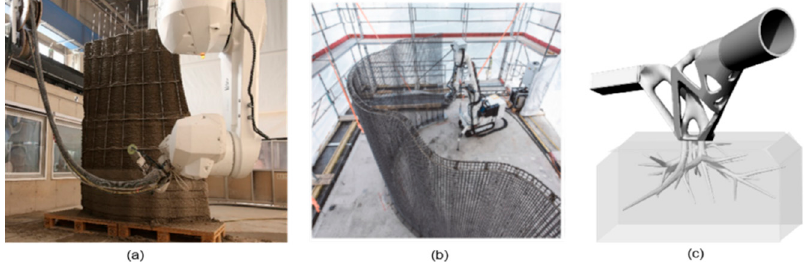
Figure 1. ( a ) Construction of a reinforced concrete wall in the digital building fabrication laboratory (DBFL) at the Institute for Structural Design (ITE). ( b ) Curved mesh of conventional reinforcement bars constructed by an in situ fabricator [30], reproduced with permission from Norman Hack, Ph.D. Thesis: Mesh Mould: A Robotically Fabricated Structural Stay-in-Place Formwork System; published by ETH Zurich, 2018. ( c ) Root-like structure for anchoring steel components in concrete.